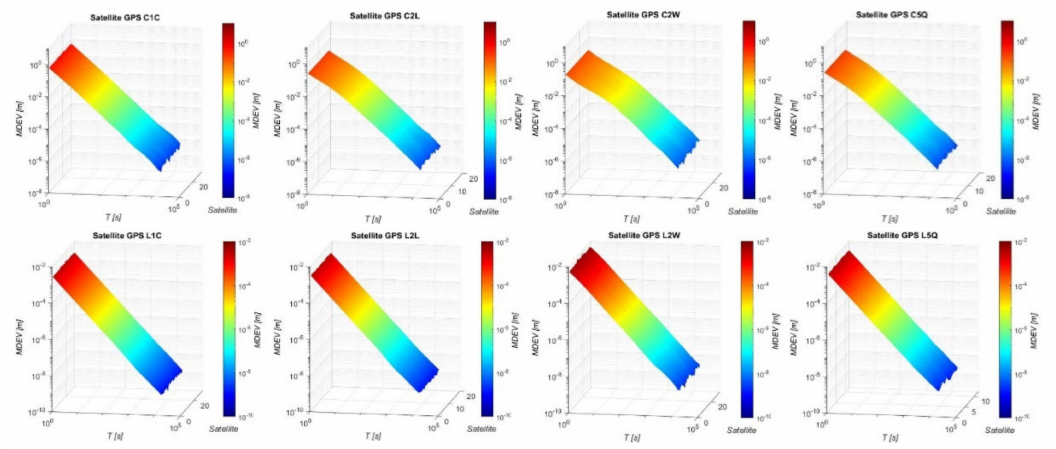
Figure 12. MDEV of the analyzed observation type for GPS satellites.